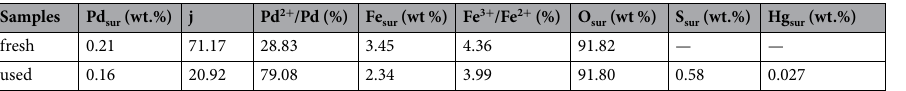
Fig. 9. The peaks corresponding to oxygen, iron, palladium and carbon were found in the survey spectra (Fig. 9a). Especially, the peaks assigned to sulfur were also observed in the used Fe 3 O 4 –NH 2 –Pd (Fig. 9a). It indicated that some sulfur species were absorbed on the surface of the Fe 3 O 4 –NH 2 –Pd. XPS spectra of Pd 3d were showed in Fig. 9b. The binding energy of 335.75 eV (Pd 3d 5/2 ) and 341 eV (Pd 3d 3/2 ) for both the fresh and used Fe 3 O 4 –NH 2 –Pd were assigned to Pd° 31 . According to the literature 32 , the binding energy of Pd° (Pd 3d 5/2 ) was 335.1 eV. However, it is found in this study that the Pd 3d 5/2 peaks shifted to higher values as a result of the presence of the surrounding positively charged ammonium groups. It implied the existing of –NH 2 group can stable Pd on the surface of the Fe 3 O 4 –NH 2 nanoparticles. The unreacted Pd° and Pd-Hg amal- gam formed during the Hg° removal can be found in the used sample 8 . The binding energy of 337.4 eV, 336.9 eV (Pd 3d 5/2 ) and 342.7 eV, 342.2 eV (Pd 3d 3/2 ) could assign to Pd 2 + . The Pd 3d 3/2 peaks also shifted to higher values due to the presence of ammonium groups 33 . Pd 2 + species in the fresh sorbent could be assigned to PdO that were from the oxidation of the Pd° by the lattice oxygen of Fe 3 O 4 . PdO can react with H 2 S to form PdS. Pd 2 + on the surface of the used and the regenerated sorbents may be assigned to PdS. The intensity of the XPS spectrum peak reflects the content of the surface atom 34 . Table 1 showed the key ele- ments contents on the surface for the fresh and used Fe 3 O 4 –NH 2 –Pd based on the results of the XPS spectra. The ratio of Pd°/Pd on the surface of the fresh Fe 3 O 4 –NH 2 –Pd was 71.17%, indicating that the elemental Pd was the main composition of the fresh sorbent. It was deduced from the Pd 2 + /Pd ratio on the surface of the used Fe 3 O 4 – NH 2 –Pd sorbents (79.08%) that the Pd 2 + species was the main compositions after the removal of Hg°. The ratio the Hg° removal. It was found in Fig. 9b that only Pd 2 + of Pd existed in Fe 3 O 4 –NH 2 –Pd after three regeneration cycles while the Hg° removal efficiency sharply decreased for the Fe 3 O 4 –NH 2 –Pd after two regeneration cycles